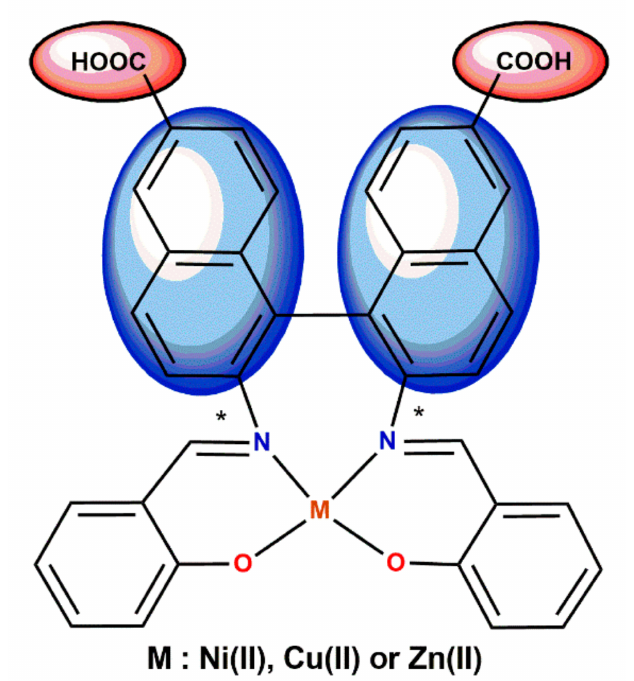
Figure 5. Schiff base complexes with both functionalities: hydrophilic carboxylic groups and π - conjugated systems (* denotes an asymmetric carbon atom) [43].